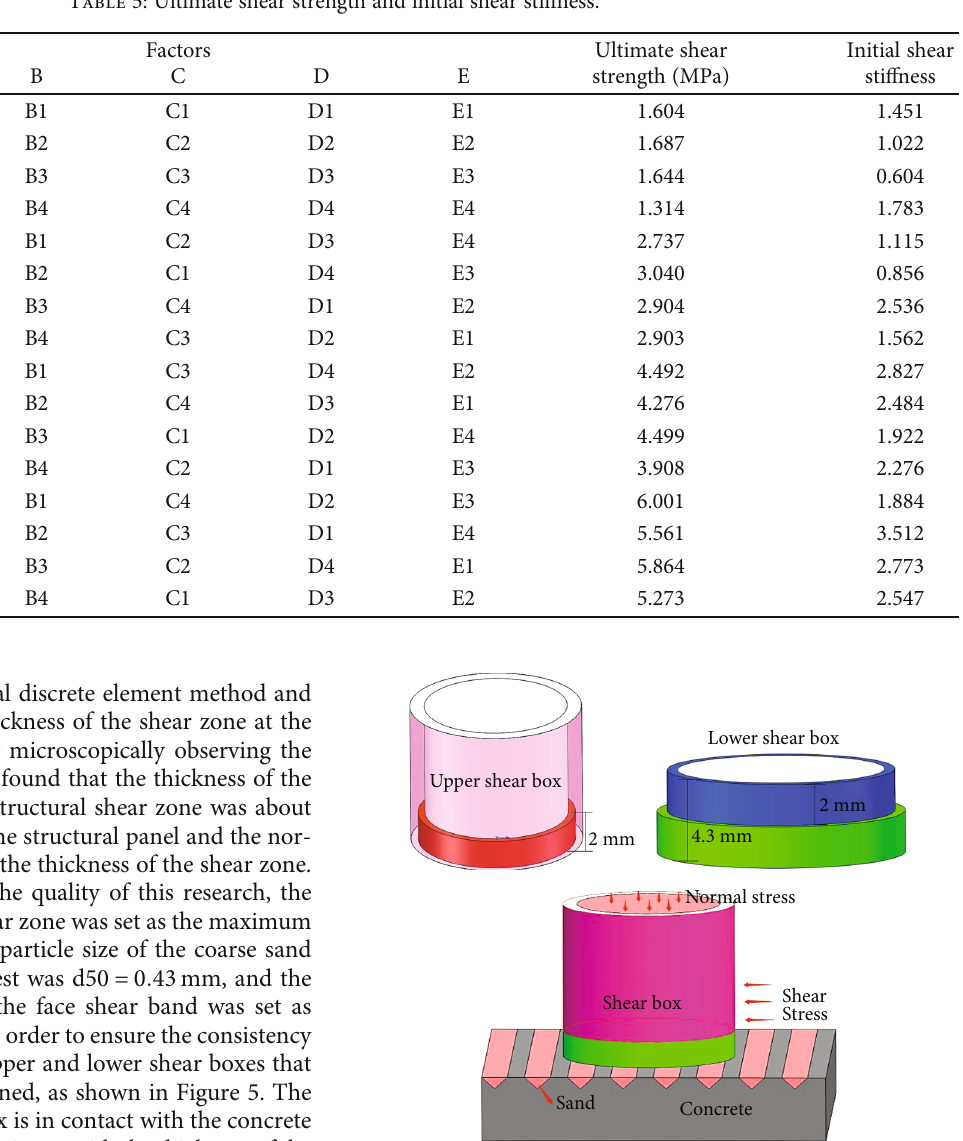
Figure 5: Layered shear